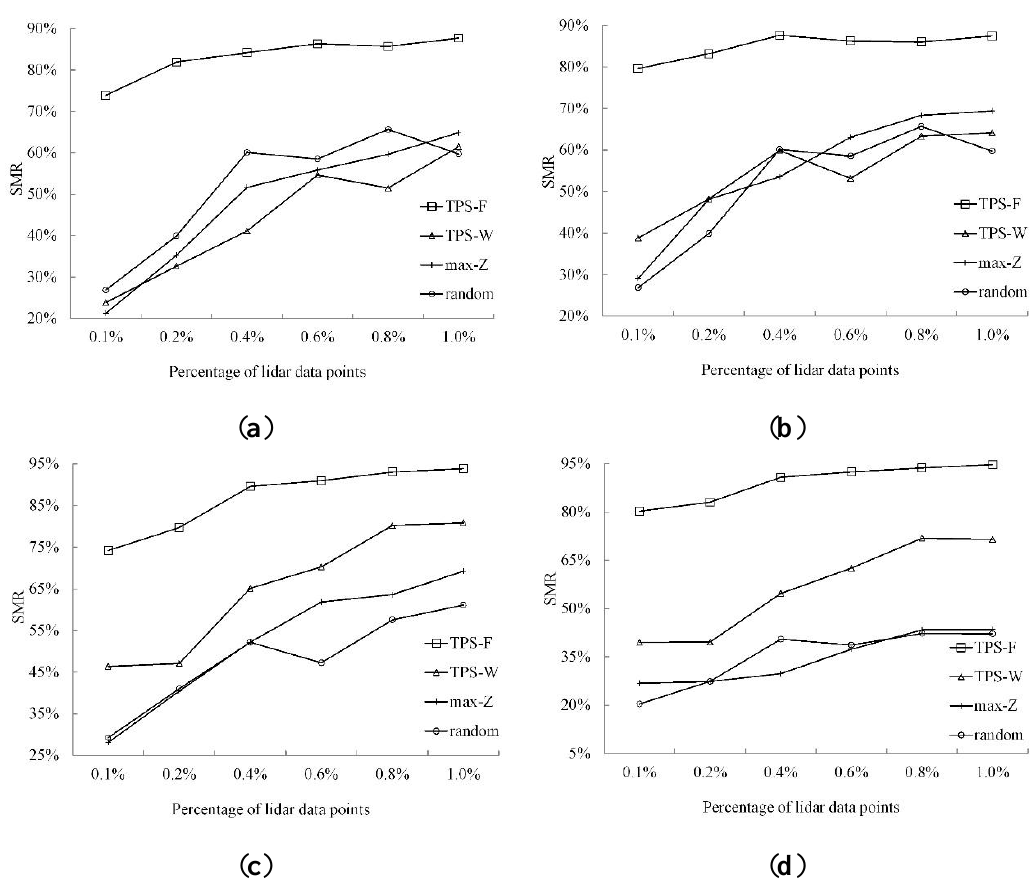
Figure 13. SMRs of TPS-F, TPS-W, max-Z and the random methods in the study sites with ( a ) flat, ( b ) undulating, ( c ) hilly and ( d ) mountainous